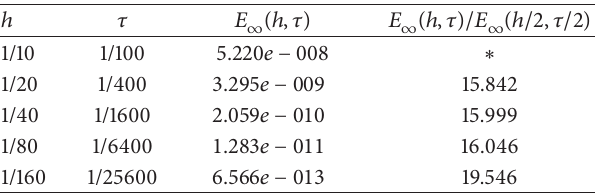
Table 2: Maximum norm errors of (54) with different step-sizes.